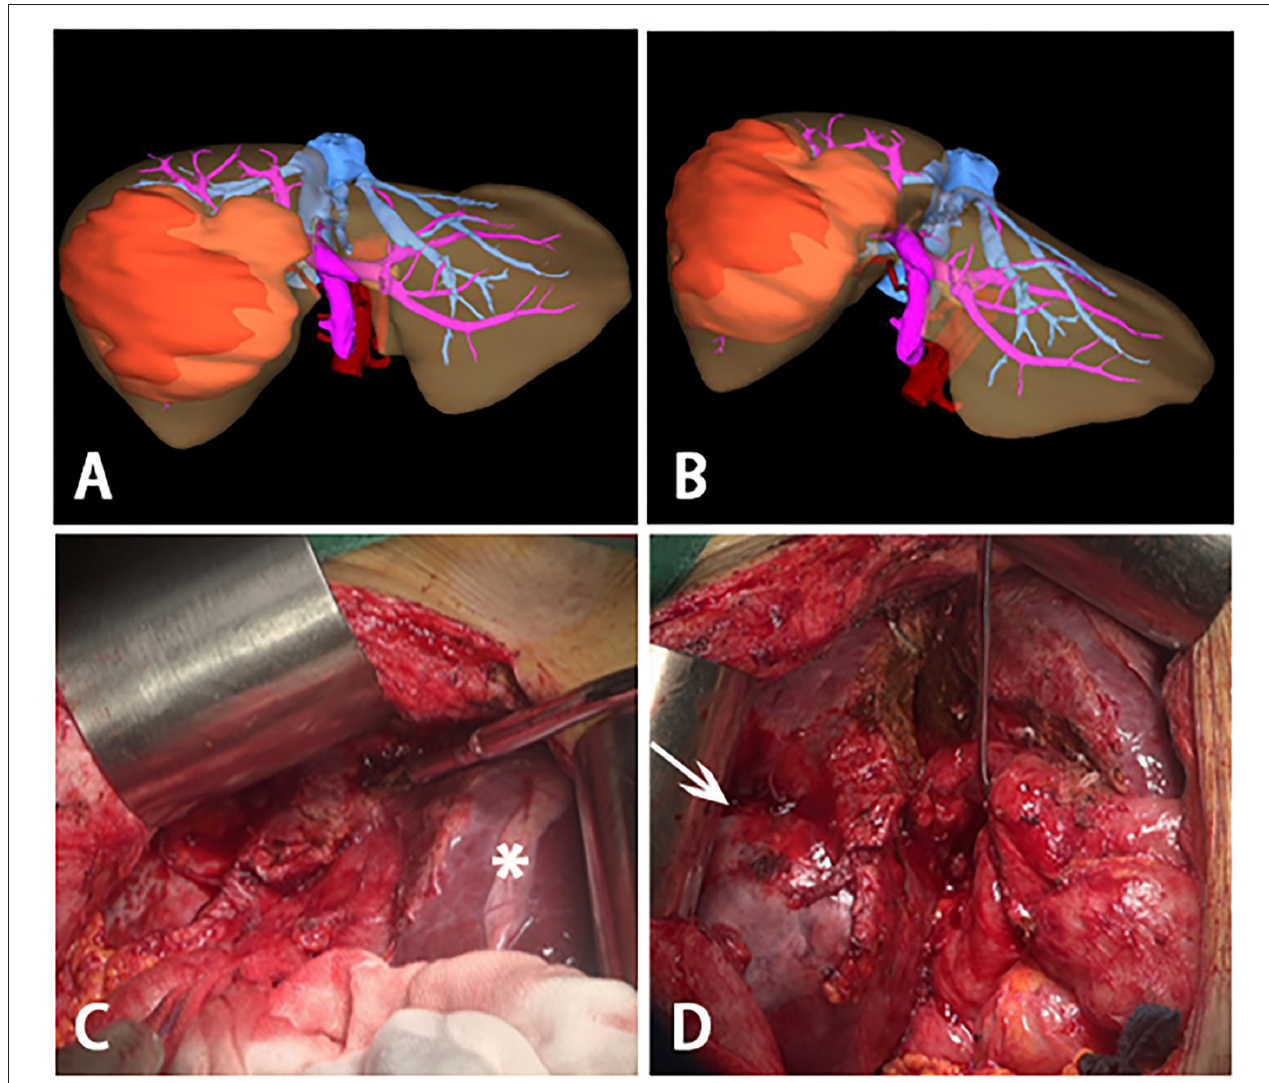
FIGURE 3 | Three-dimensional reconstructions before stage II ALPPS and intraoperative photographs during stage II ALPPS. (A,B) Three-dimensional reconstructions before stage II ALPPS, a large tumor was on the right lobe of liver and most of the liver parenchymal between right and left was divided. (C) hypertrophy of the left lateral segment (asterisk). (D) process to remove the huge tumor (white arrow)- right